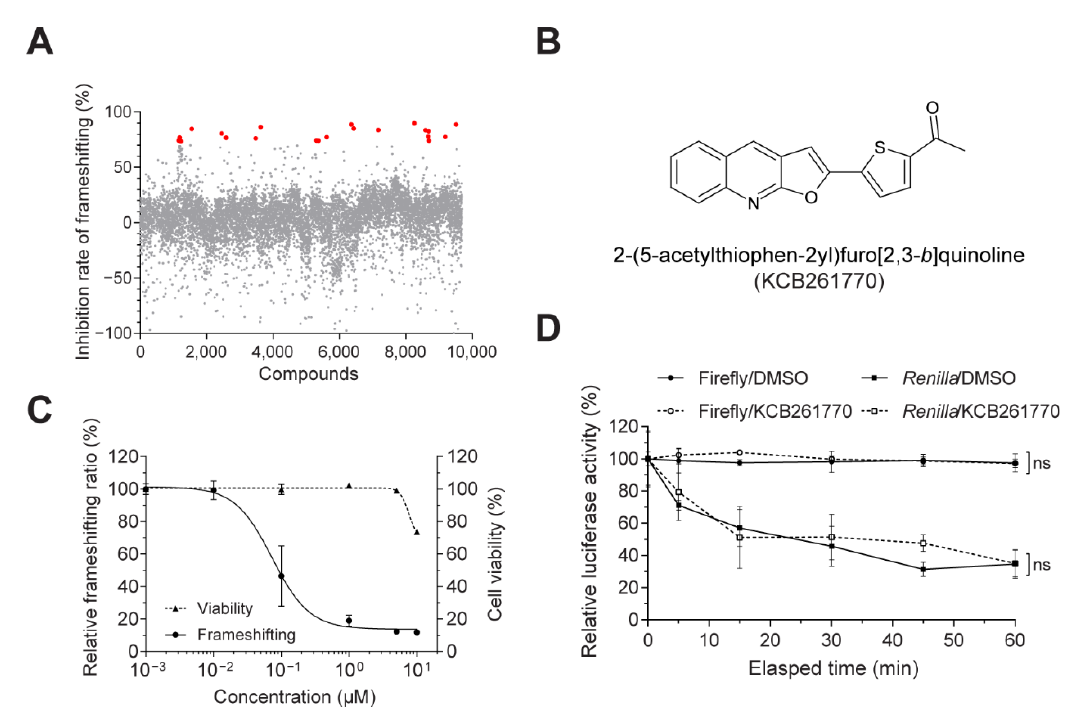
Figure 2. A novel compound efficiently inhibiting MERS-CoV frameshifting. ( A ) Screening of compounds inhibiting the MERS-CoV − 1 PRF frameshifting. Chemical compounds with inhibitory effects over 70% are indicated with red dots. ( B ) Chemical structure of the selected compound, 2-(5-acetylthiophen-2yl)furo[2,3- b ]quinoline (KCB261770). ( C ) The relative frameshifting ratio of MERS-CoV − 1 PRF (solid line, left y -axis) and cell viability (dashed line, right y -axis) were tested with increasing concentrations of KCB261770. ( D ) Cell lysates harboring MERS-CoV − 1 PRF plasmids were incubated with compound KCB261770 for 60 min. The firefly and Renilla luciferase activities relative to the initial time points were monitored. The luciferase activities of the samples, including the compound-treated samples, were compared to those of the luciferase activities of the DMSO-treated samples at 0 time, which was set to 100%. DMSO was used as a negative control. ns; not significant (two-way ANOVA with Sidak’s multiple comparisons test).